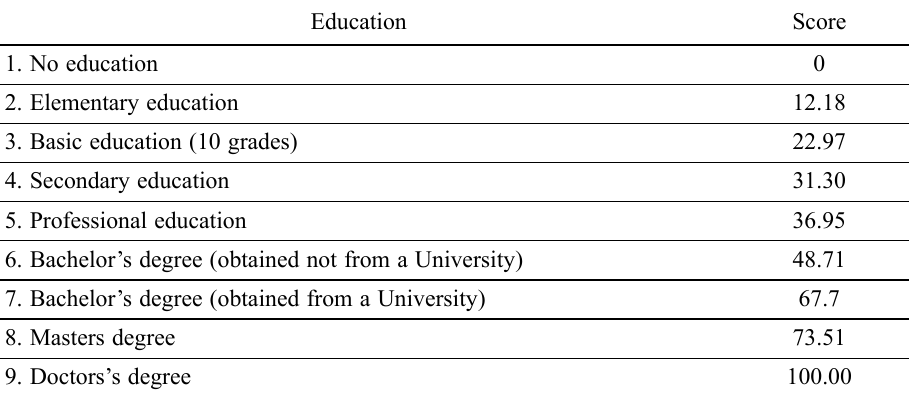
Table 2. Cumulative vector of the knowledge potential distribution according to the level of